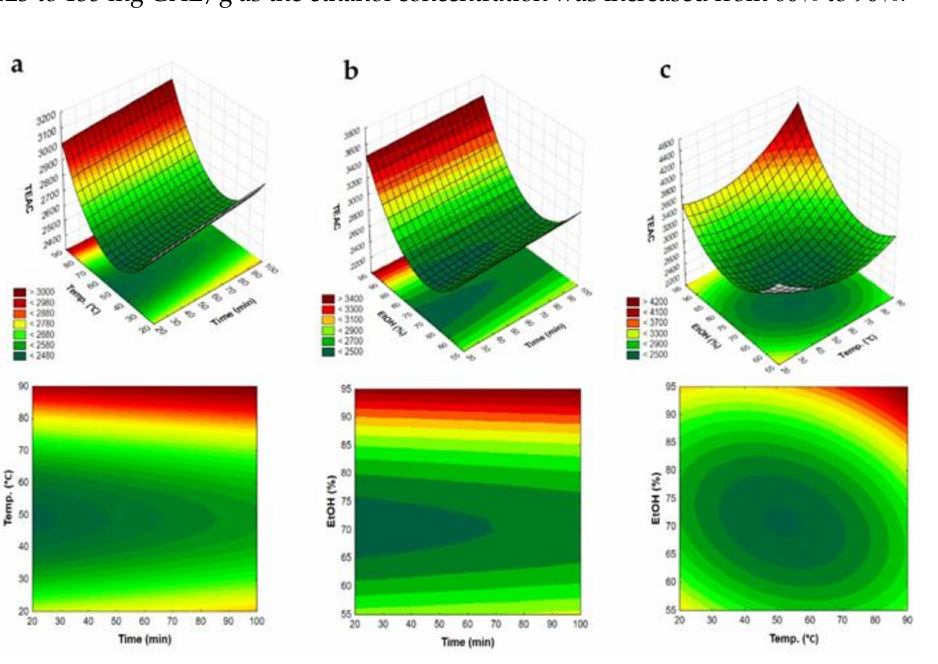
Figure 1. Response surface plot showing the combined effect of temperature ( ◦ C) ( a ), time (min) ( b ), and EtOH (%) ( c ) on the TEAC of Brazilian red propolis